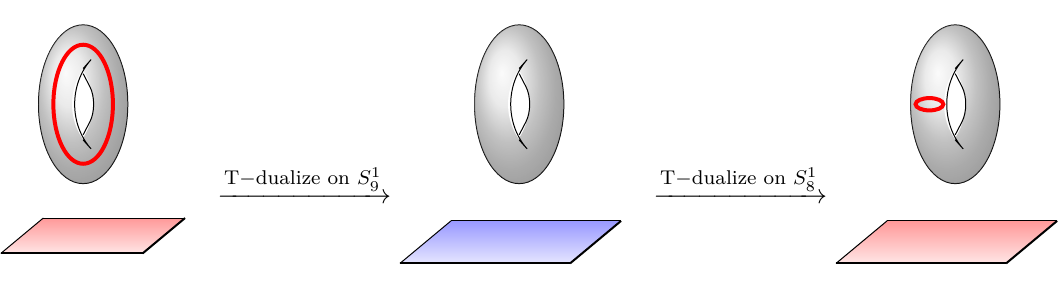
, we T-dualize on 9 gives a 8